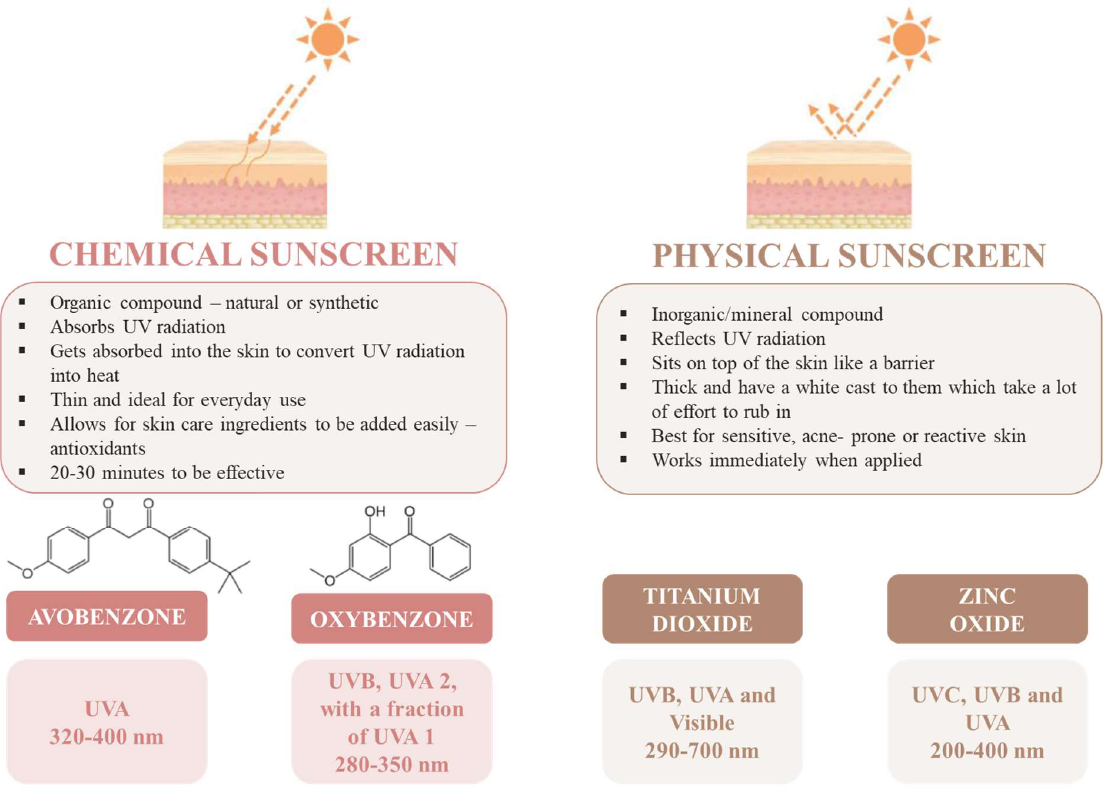
Figure 2. Chemical sunscreen and physical sunscreen, and some examples of the main UV filters used in each case. The wavelength ranges correspond to the light absorption.